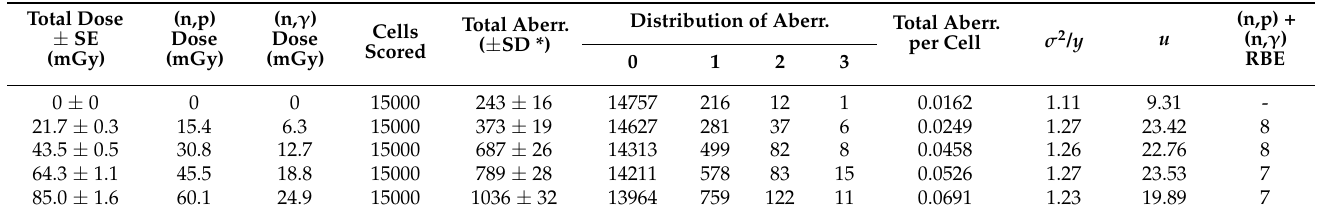
Table 4. CBMN distribution in the peripheral blood lymphocytes of three donors and dose-specific RBE values. Values of u demonstrating non-Poisson over-dispersion are highlighted in bold. Standard error of the mean represents the error for the dose across three donors.